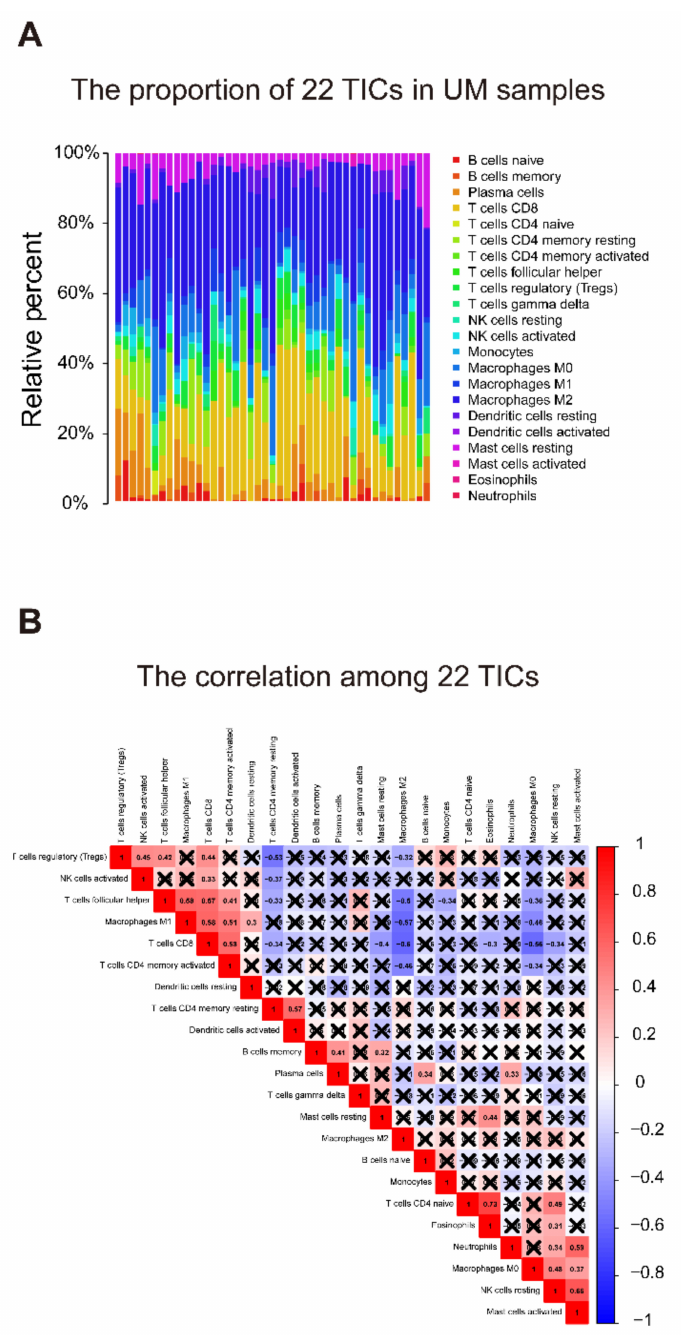
Figure 9. TIC distribution map and correlation analysis of UMs in the training cohort. ( A ) The bar graph shows the relative content distribution of 22 TICs of UMs in the training cohort. Columns represent UM cases. ( B ) The heatmap shows the correlation between 22 TICs. The color and number in each box indicate the coefficient between the two TICs. The coefficient of X-shaped coverage is not significant. Correlation test is conducted by the Pearson coefficient. p -value < 0.05 is the significance threshold. UM: uveal melanoma; TIC: tumor-infiltrating immune